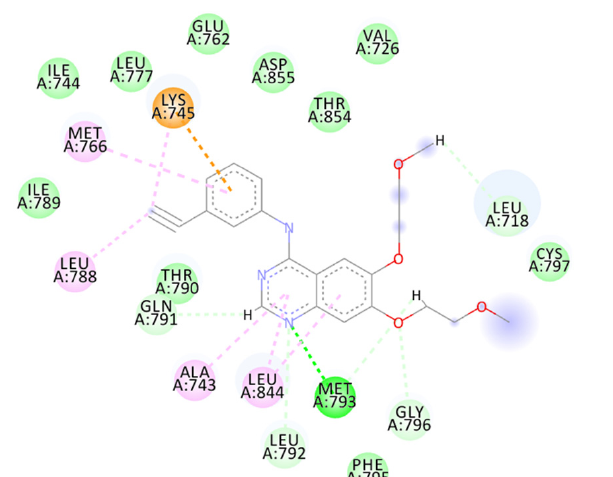
, hydrogen Figure 8. Two-dimensional interaction of erlotinib to G779A, Q791A, I853A, and D855A ( , hydro-